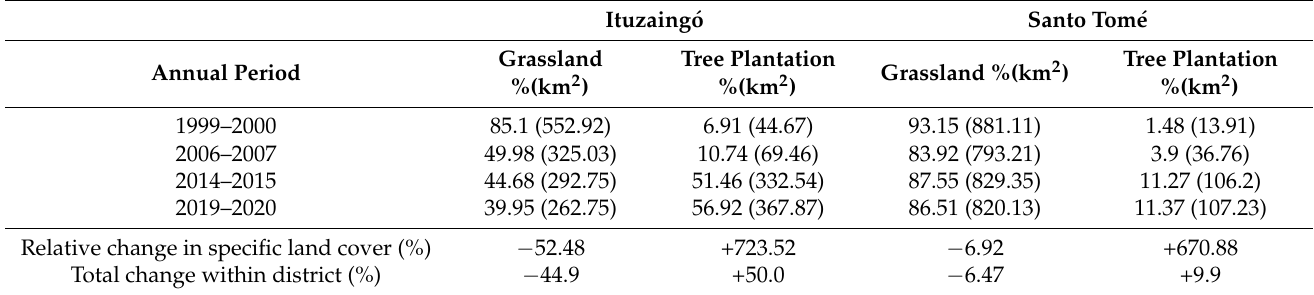
Table 5. Area of each land cover class for the Aguapey VGA’s districts in four annual periods based on the unsupervised classification thematic maps.